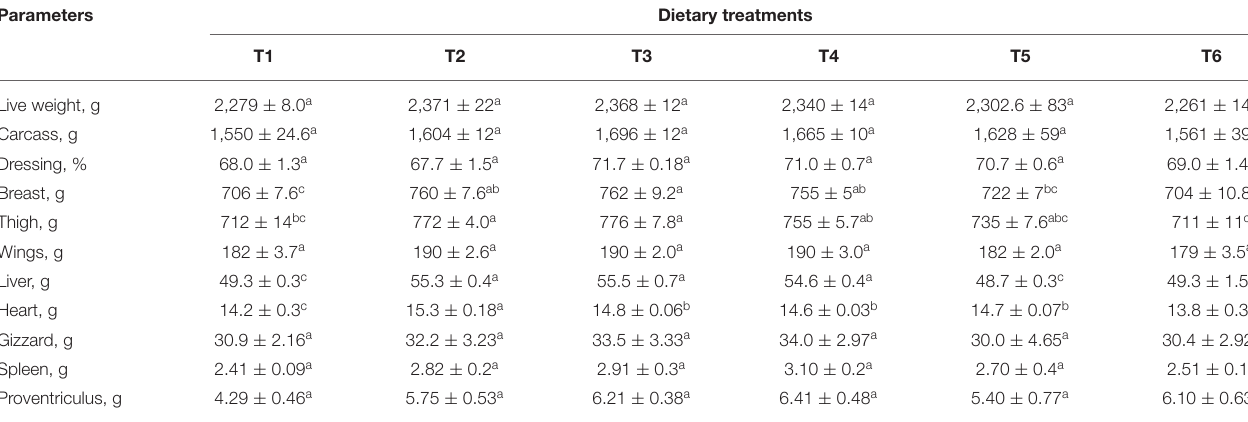
TABLE 3 | Effect of different dietary treatments on carcass characteristics and organ weight of broilers on day 42 of age ( n = 6 chicks per treatment, mean ± SE). Parameters Dietary